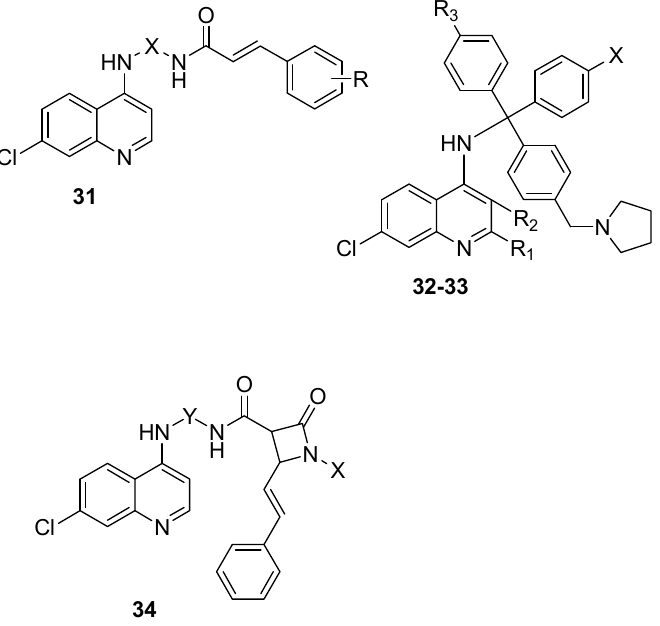
Figure 6. Hybrid compounds containing quinoline derivatives and antibacterial agents.